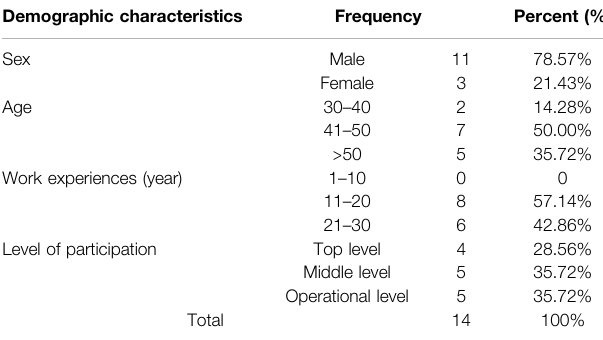
TABLE 1 | Demographic characteristics of the participants in the study of the challenges of Vision Zero implementation in